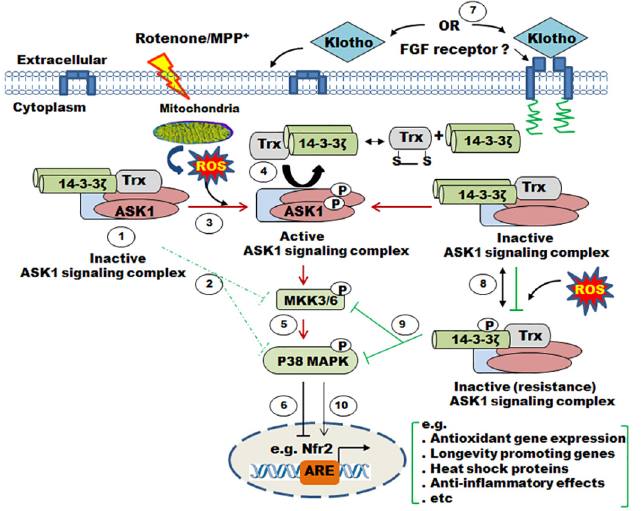
Fig 9. Model describing oxidative stress response in Klotho responsive cells and tissues. ( 1 – 2 ) In normal unstressed cells and tissues, 14-3-3 ζ and thioredoxin cooperate with other cytosolic proteins to inhibit the ASK1 signaling complex with concomitant downstream reduction in MAPKs phosphorylation level. ( 3 – 6 ) In an oxidizing environment generated by reactive oxygen species (ROS) via mitochondrial electron transport chain dysfunction induced by rotenone, ASK1 dissociates from thioredoxin/14-3-3 ζ , becomes phosphorylated (activating ASK1 signaling compex) and, in turn, phosphorylates downstream MAPKs, including p38. These cascades of events inhibit nuclear translocation of transcription factors such as Nrf2, leading to suppression of antioxidant and longevity-promoting genes. Puzzling is our observation that 14-3-3 ζ